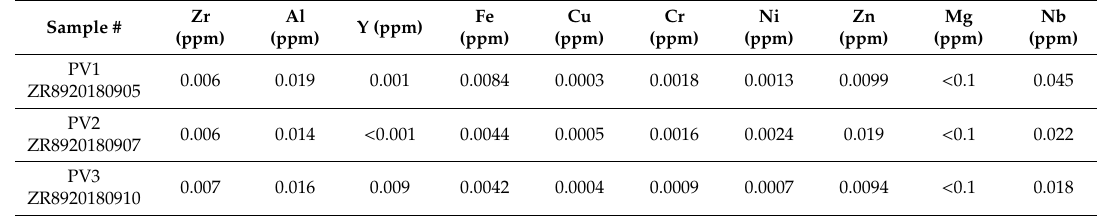
Table 2. ICP-MS analysis of three consecutive 89 Zr production